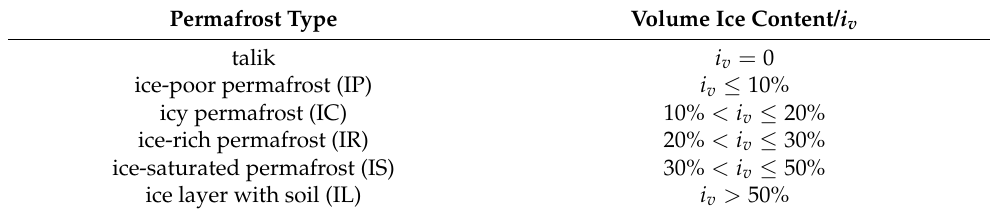
Table 6. Classification of volume of ice